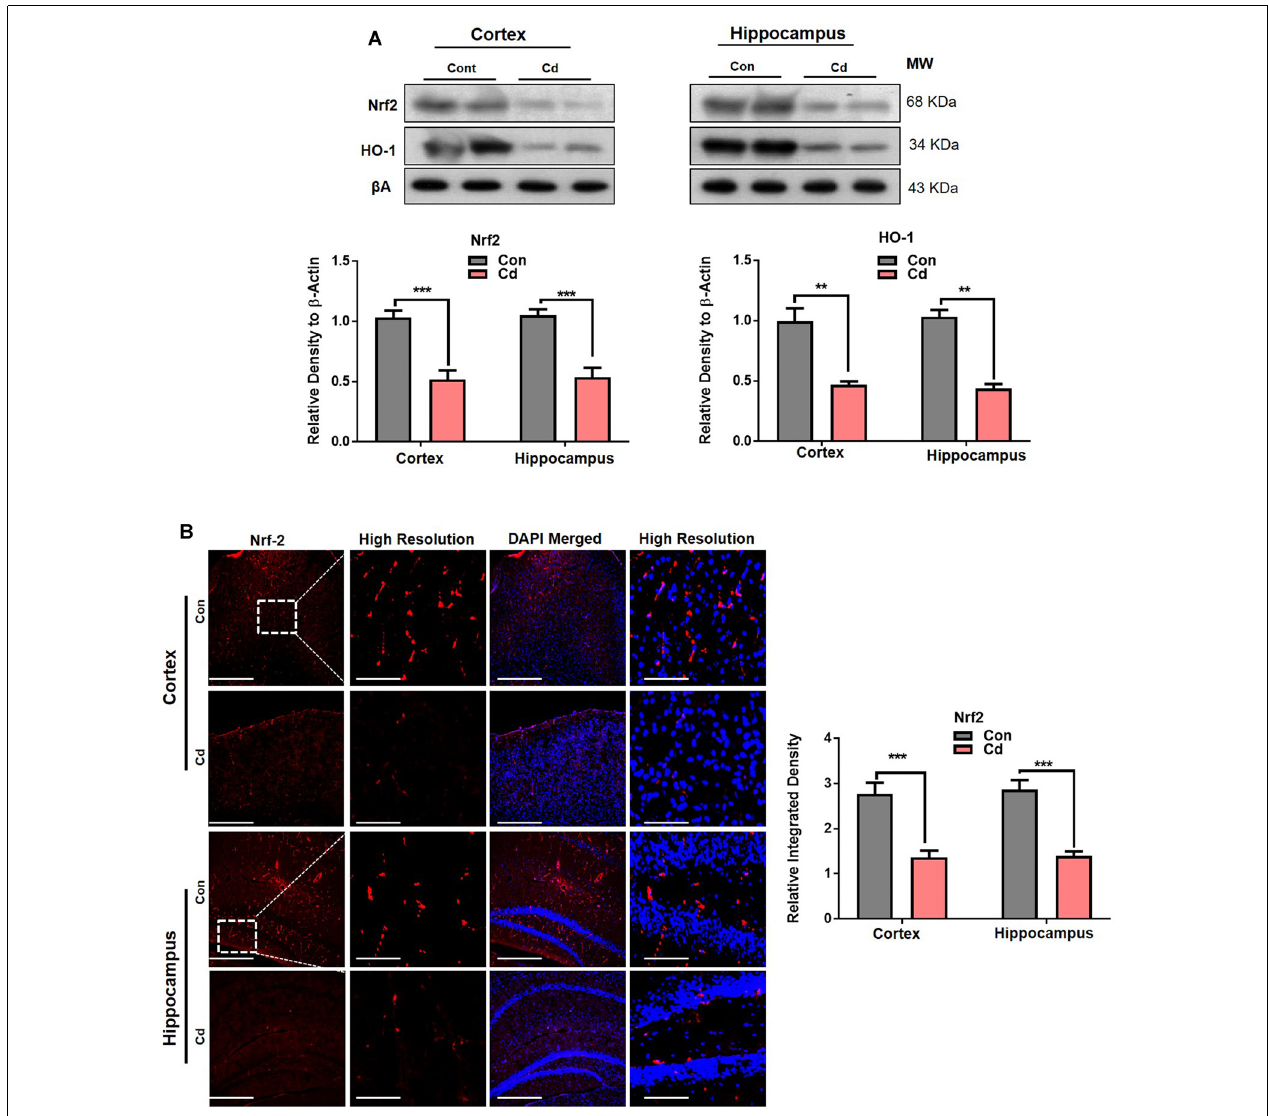
FIGURE 5 | Cd exposure perturbed antioxidant Nrf2/HO-1 pathways. (A) The Western blot images against Nrf2 and HO-1 in the cortical and hippocampal regions of the brain and their respective histograms. β -Actin was used as a loading control. The histograms represented as the means ± SEM ( n = 7 mice/group) for three repeated independent and reproducible experiments. Significance = ** p < 0.01, *** p < 0.001; Student’s unpaired t -test. See Supplementary Figure 2 for uncropped and original blots. (B) Representative immunofluorescence images of Nrf2 (red: TRITC and blue: DAPI) in the cortical and hippocampal regions of the mouse brain. The histograms represented as the means ± SEM for n = 5 mice per group, and the number of independent experiments = 3. Magnification: 10 × . Scale bar = 50 µ m. Significance = *** p <